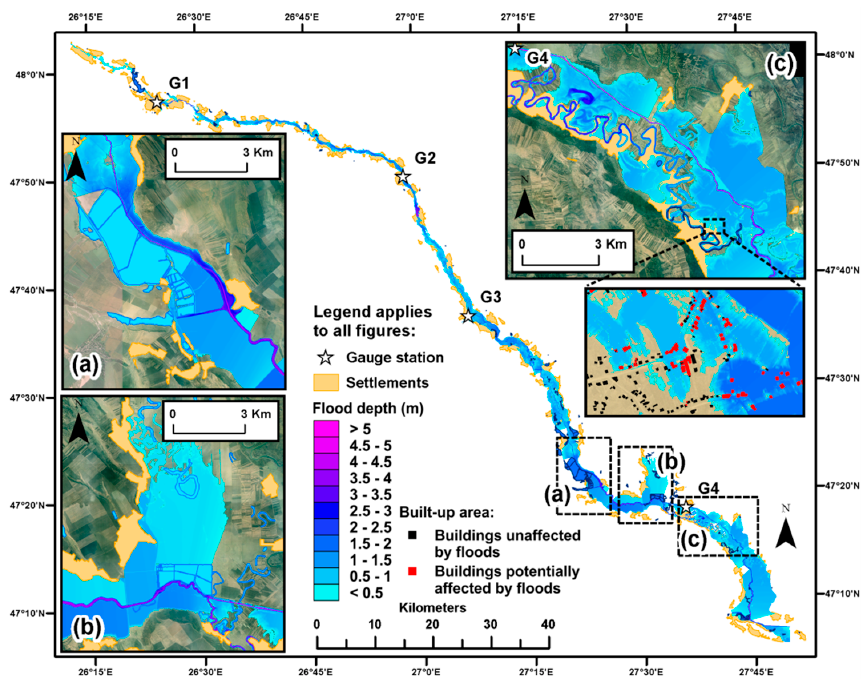
Figure 7. Flood depth derived from 1D HEC-RAS modeling based on LiDAR data (0.5 m spatial resolution) and Q max . (m 3 /s) flow rates with 0.1% (1000-year) recurrence intervals estimated for each gauging station (G1, G2, G3, and G4). The 0.1% (1000-year) flood depth pattern is highlighted in sections ( a – c ).